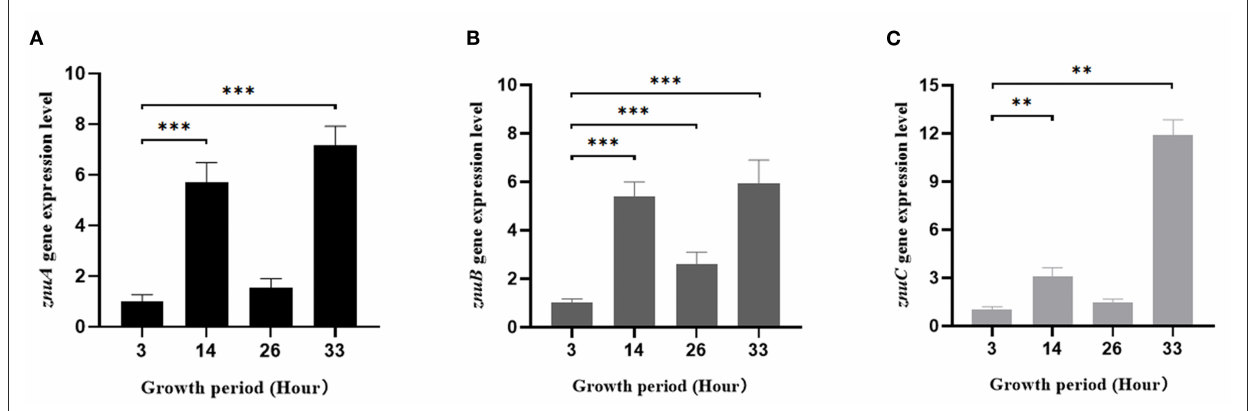
FIGURE7 Determination of the expression levels of znuA , znuB, and znuC in different growth stages. The expression levels of znuA (A) , znuB (B) and znuC (C) in different growth period. Data were presented as mean ± standard deviation (SD) ( n = 3). ** P < 0.01, *** P < 0.001.